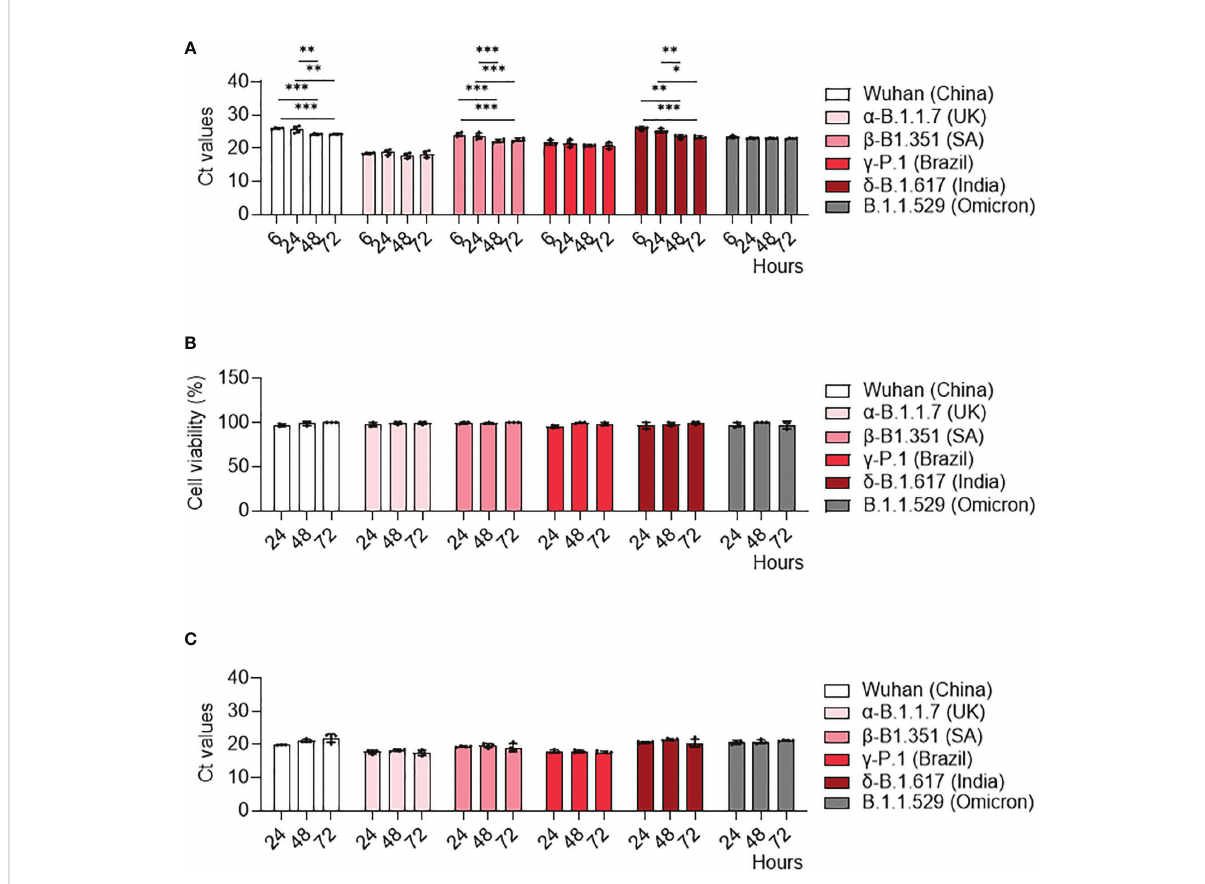
FIGURE 1 MDM infection with SARS-CoV-2 variants. MDM were infected with SARS-CoV-2 variants including Wuhan (China), a -B.1.1.7 (United Kingdom, UK), b -B.1.351 (South Africa, SA), g -P.1 (Brazil), d -B.1.617 (India) and B.1.1.529 (Omicron) (0.1 MOI) for 6, 24, 48 and 72 hours. (A) SARS-CoV-2 was quanti fi ed in cells as Ct values by RT-PCR. (B) Cell viability was tested at 24, 48 and 72 hours post-infection. (C) SARS-CoV-2 replication was quanti fi ed by RT-PCR in cell supernatants and expressed as Ct values. Data values represent the mean ± SD from 4 healthy donors whose experiments were carried out in triplicate. Statistical analysis was performed with two-way ANOVA and Tukey ’ s multiple comparison test. * p ≤ 0.05 , ** p ≤ 0.01 and *** p ≤ 0.001